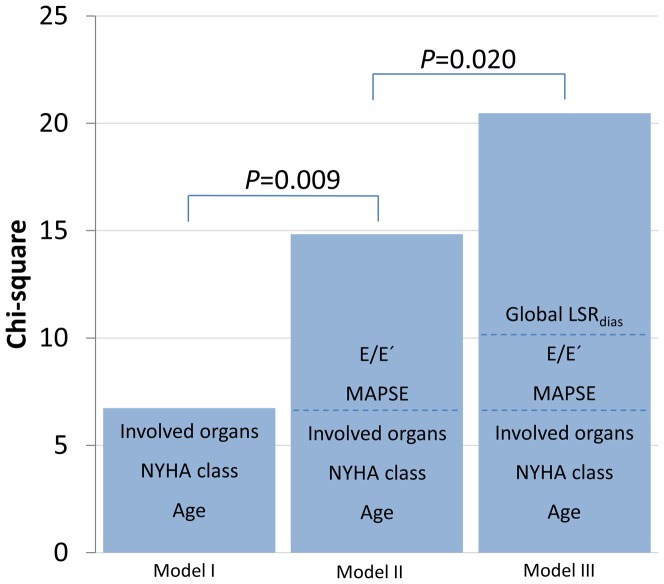
Incremental model performance for predicting prognosis assessed by starting with the clinical variables (Model I: age, NYHA class, and number of non-cardiac organs involved), followed by the conventional echocardiographic parameters (Model II: adding MAPSE and E/E′ to model I), and finally by adding advanced global LSRdias (Model III).MAPSE: mitral annular plane systolic excursion; E/E′: early diastolic peak filling velocity to tissue Doppler early diastolic septal mitral annular velocity ratio. LSRdias: longitudinal peak early diastolic strain rate.